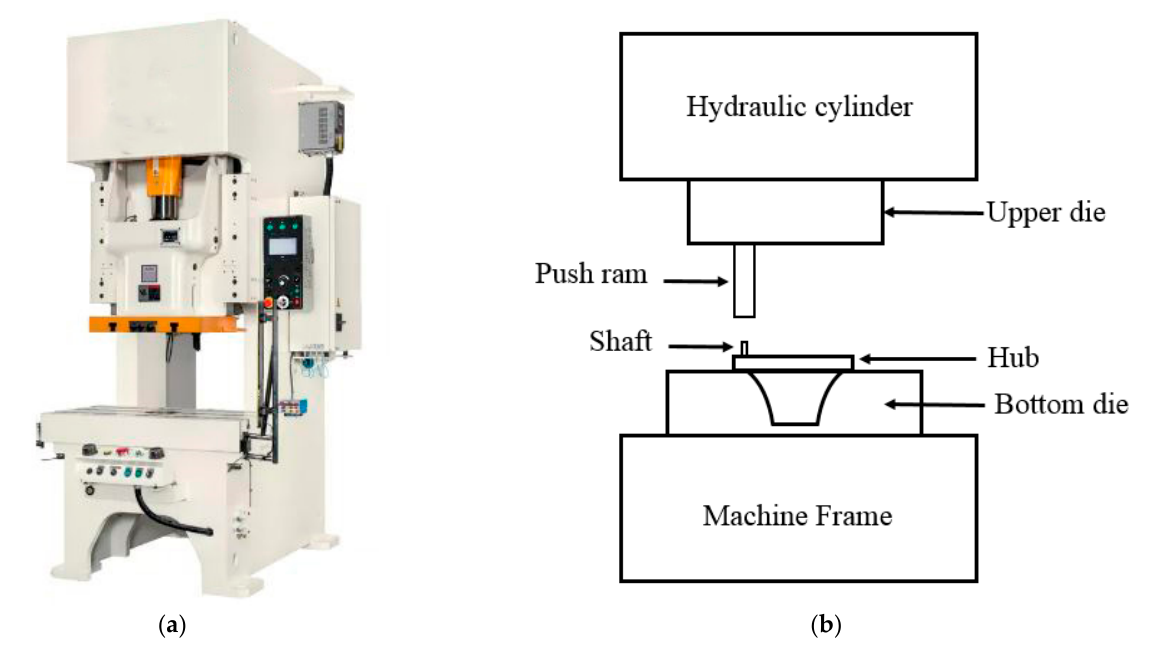
Figure 7. Experimental equipment: ( a ) photo of machine used in experiments and ( b ) schematic of the machine.